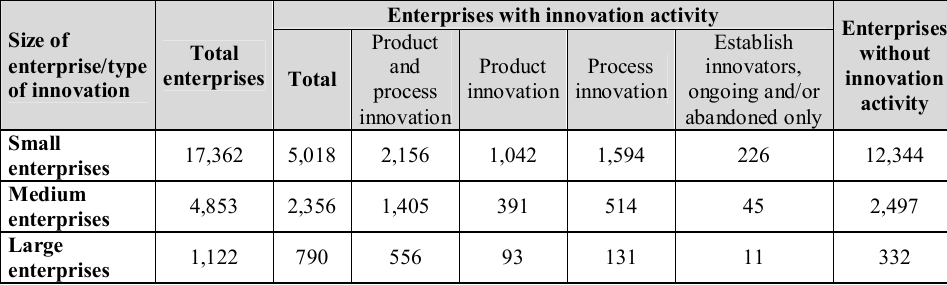
Table 5 - Enterprises with innovation activity according to their size and the type of implemented innovation in Czech Republic Size of